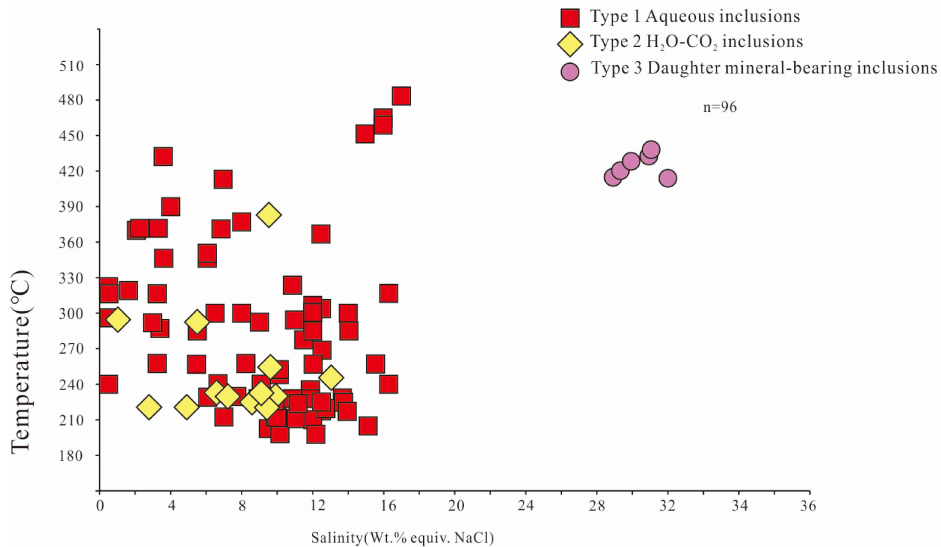
Figure 10. Temperatures ( ◦ C) of total homogenization (T h(tot) ) versus salinity (wt.% equiv. NaCl) for different types of fluid inclusions trapped in quartz in the Xiawolong gold